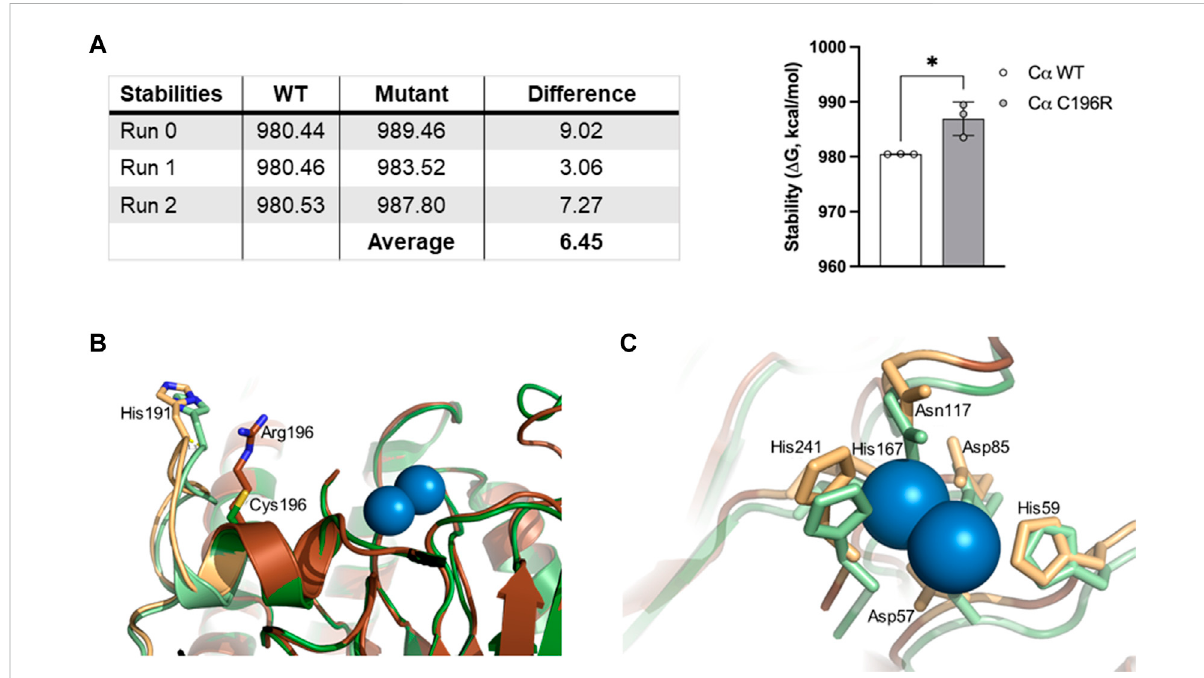
Predicted models for changes in stability and structure of the C α p.Cys196Arg variant. (A) Changes in protein stability between PPP2CA WT and p.Cys196Arg variant were predicted by the FoldX algorithm, based on crystallographic data by Cho and Xu (2007) (PDB ID: 2IAE). Δ G values (in kcal/ mol)forWTorvariantproteinsaredisplayedinthetable(obtainedinthreedifferentruns).Theaveragedifferencein Δ Gbetweenbothproteins( ΔΔ G) is shown in the graph (*, p < 0.05). Values in ΔΔ G above 0.5 kcal/mol are considered signi fi cant. (B,C) AlphaFold2-predicted structural changes in the C α p.Cys196Arg variant (in brown) compared to WT (in green) at the interface with His191 in the loop switch (panel B) and within the catalytic site (panel C). Catalytic metal ions (in blue) and metal coordinating residues (Asp57, His59, Asp85, Asn117, His167, and His241) are indicated.